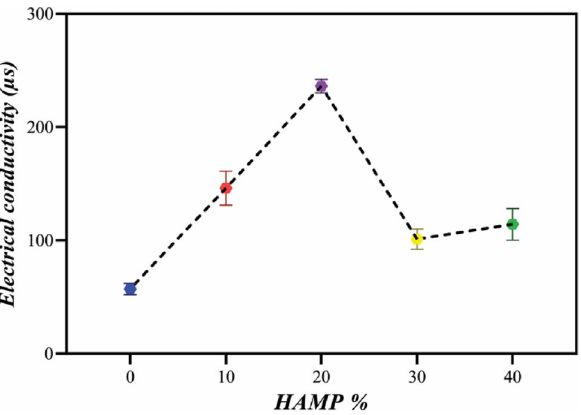
Figure 4. Electrical conductivity of electrospinning solutions with different amounts of HAMP.